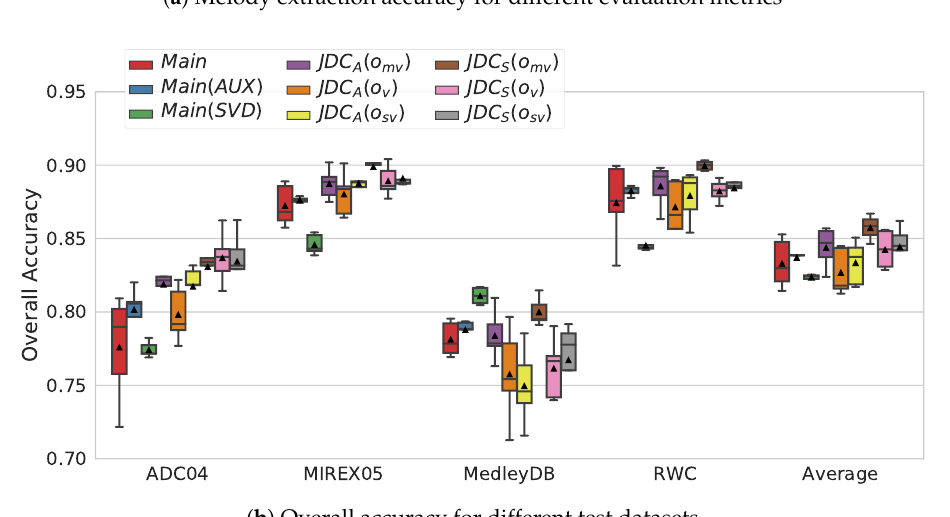
Figure 3. Performance of melody extraction on the Main , Main ( AUX ) , Main ( SVD ) , and JDC networks. The reported results were averaged across five training runs with different initializations. The “average” was calculated as the average score of all songs in all datasets. The band inside the box is the median, and the black triangle indicates the mean. RPA, raw pitch accuracy; RCA, raw chroma accuracy; VR, voicing detection rate; VFA, voicing false alarm